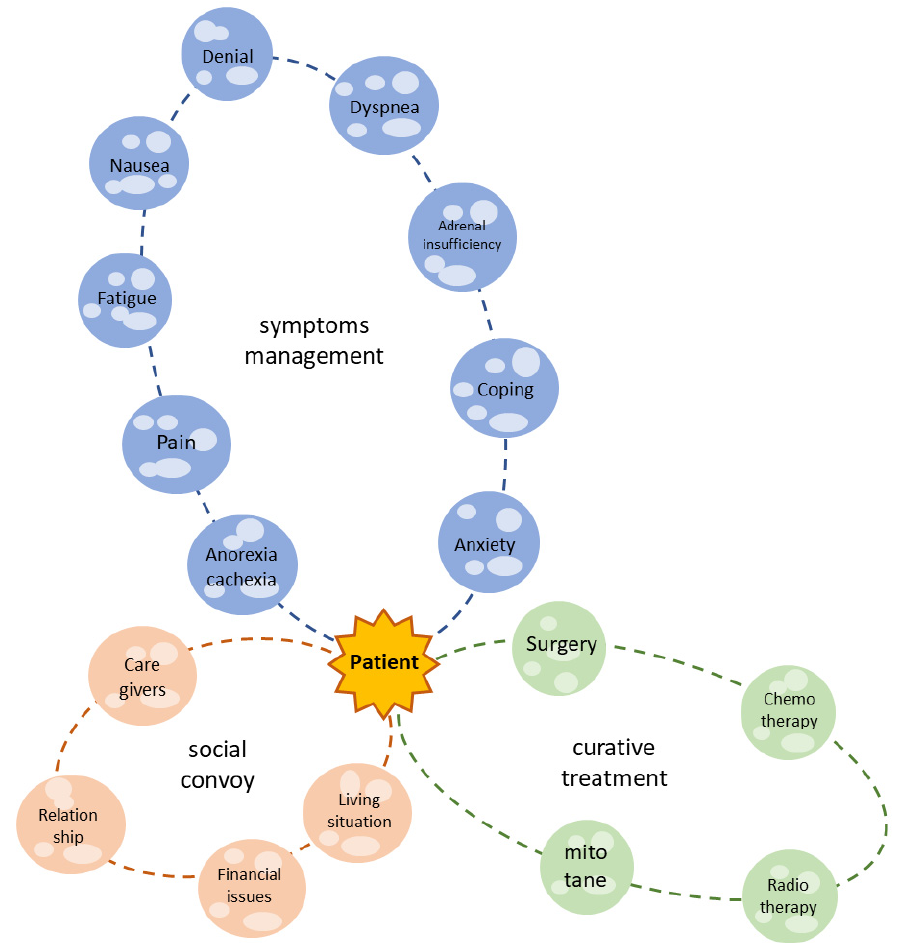
Figure 2. The patient with ACC is the center of the galaxy. The green solar system is what we actually consider as life-prolonging or curative treatment. Nonetheless, the patient experiences several symptoms (blue solar system) and lives in a social context (orange solar system), which must be considered in a modern, holistic, multidisciplinary approach.